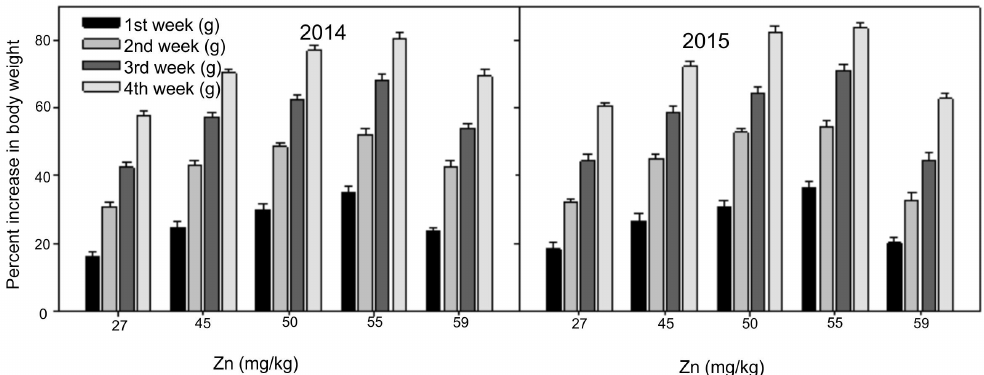
Fig. 2: Percent increase in body weight of groups of male rats after feeding with Zn biofortified rice of both years. Vertical bars above mean denote the standard error of three